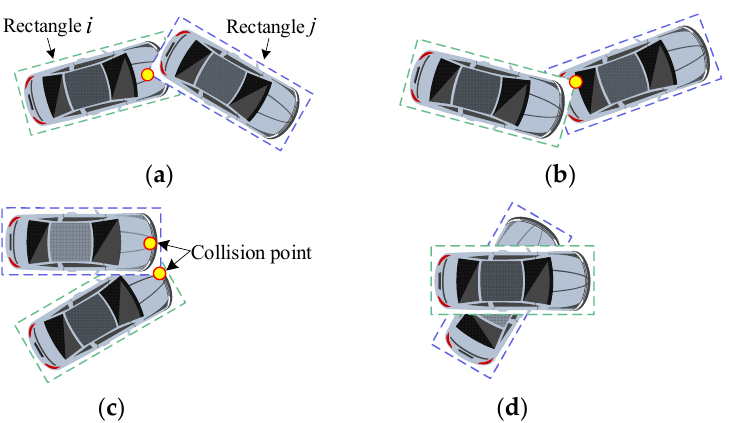
Figure 5. ( a ) A rectangle exists where a vertex collides with another rectangle; ( b ) A rectangle exists where a vertex collides with another rectangle. ( c ) Two rectangles with vertices colliding with each other; ( d ) Through collision.